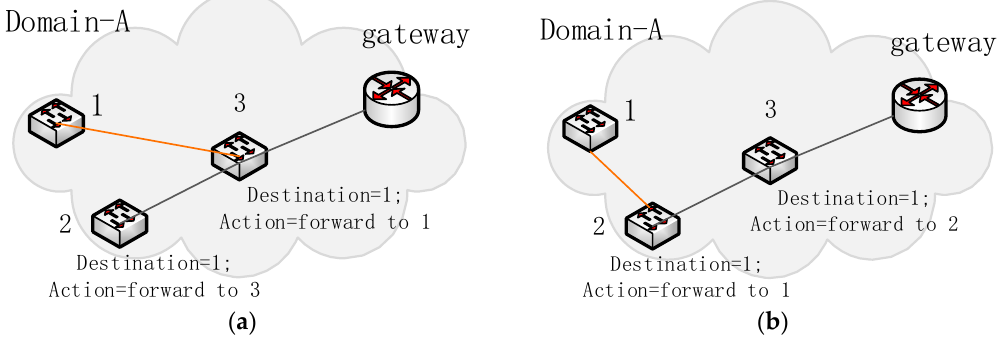
Figure 6. ( a ) Entries and topology before the controller failure; ( b ) Entries and topology after the controller failure. The orange link shows the connection relationship that changes. The entries that direct packets to switch-1 should be updated, too. direct packets to switch-1 should be updated,